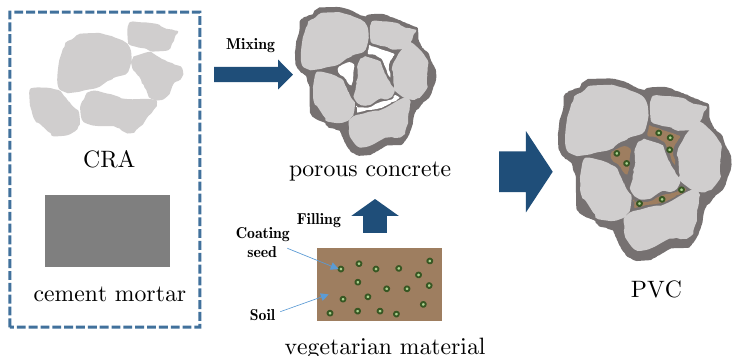
Figure 1. Schematic diagram of porous vegetarian concrete